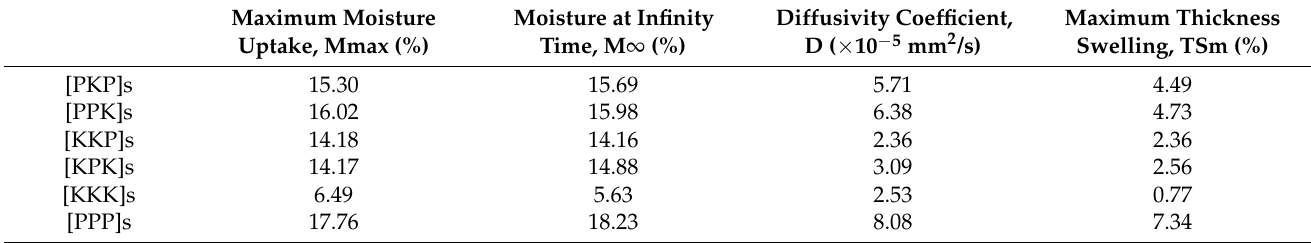
Figure 5. Thickness swelling of PALF/Kevlar-reinforced UP hybrid composite laminates with different stacking sequences. Table 4. Summary of thickness swelling of PALF/Kevlar-reinforced UP hybrid